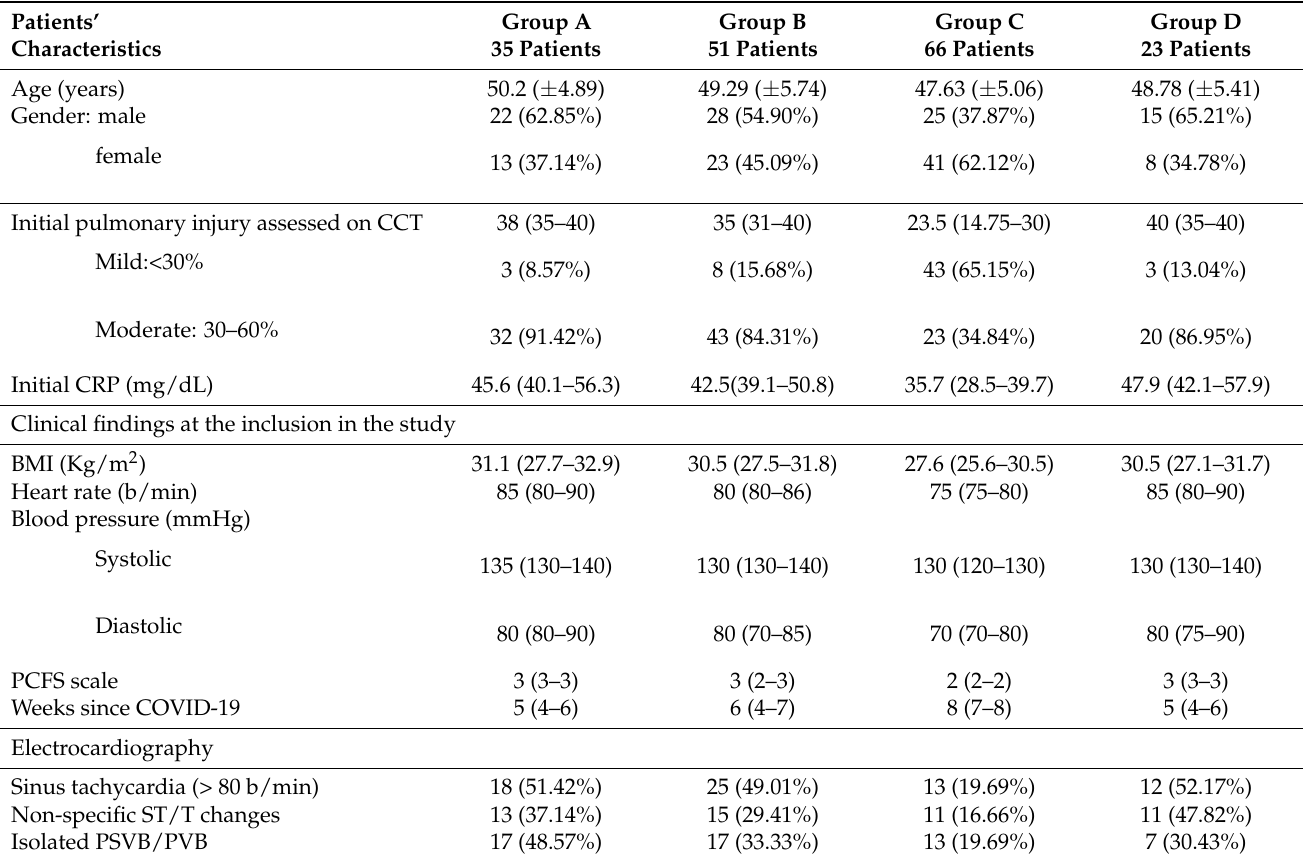
Table 1. Clinical and laboratory data of study